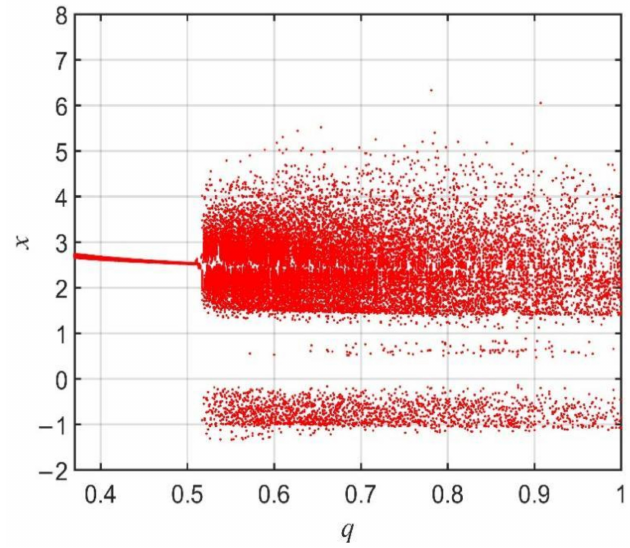
Figure 5. Bifurcation diagram of system (14) with q varying from 0.37 to 1 for a 1 =